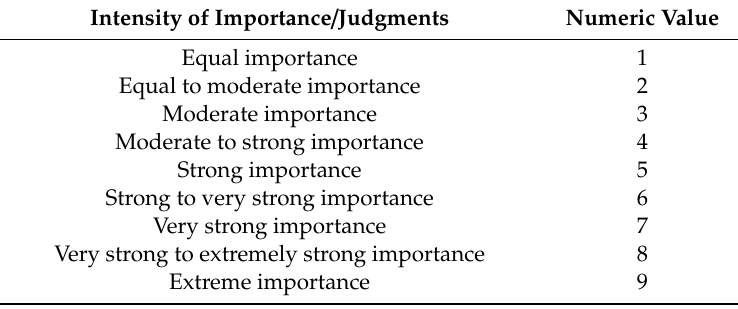
Table 2. Saaty’s pairwise comparison scale.